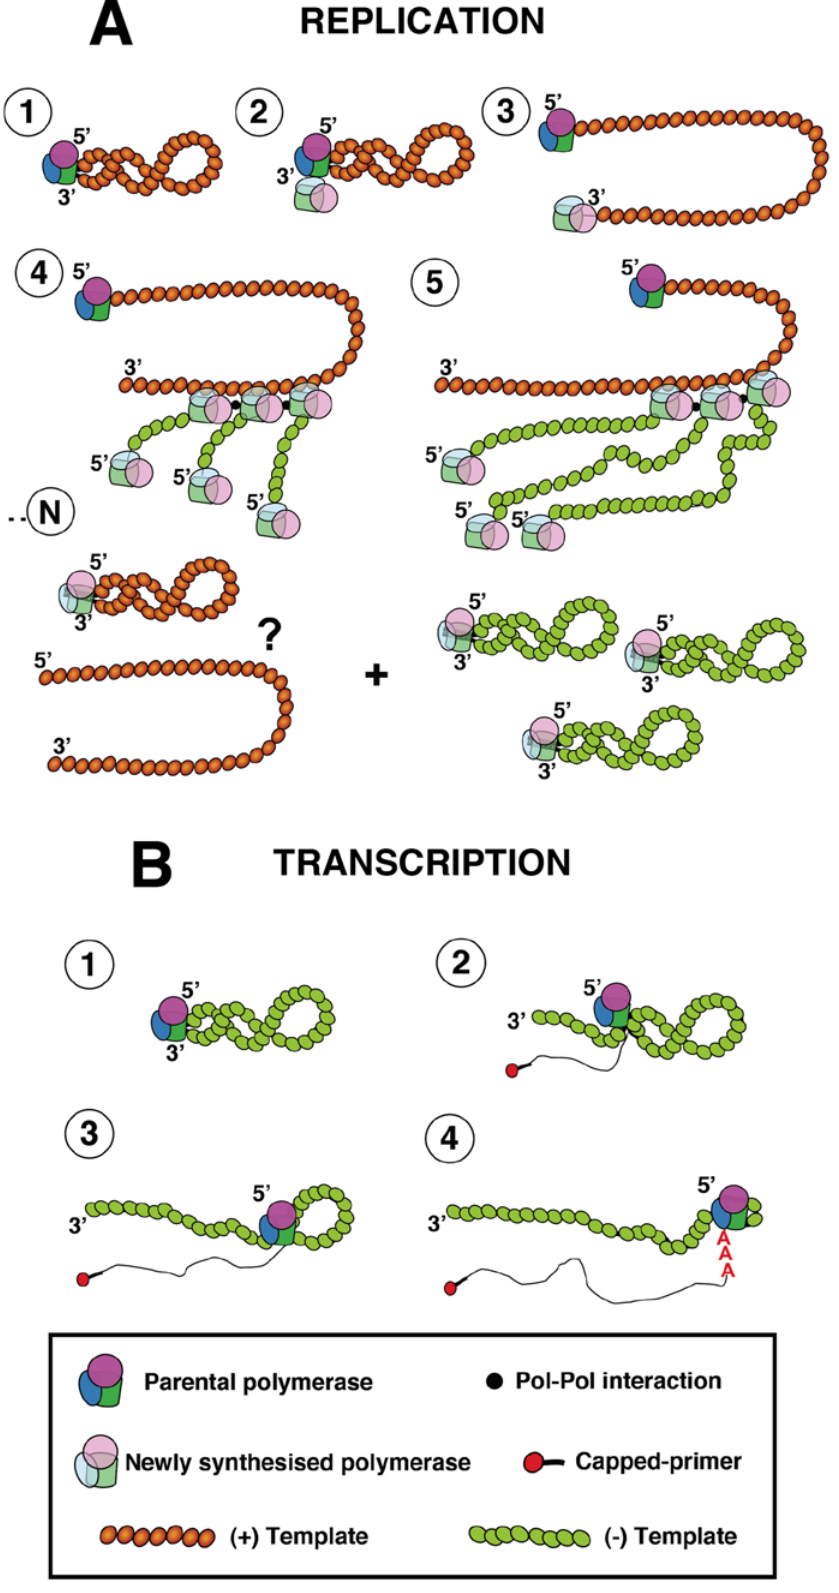
Figure 8. A model for influenza RNP replication and transcription. (A) Various steps in the process of RNP replication. The coloured NP indicates the polarity of the templates (brown: positive polarity; green: negative polarity). The parental polymerase complex is denoted by solid colours while the semi-transparent colouring indicates a newly synthesised complex. See text for details. (B) Various steps in the process of RNP transcription. The capped primer is depicted as a thick line with a red circle. See text for details.